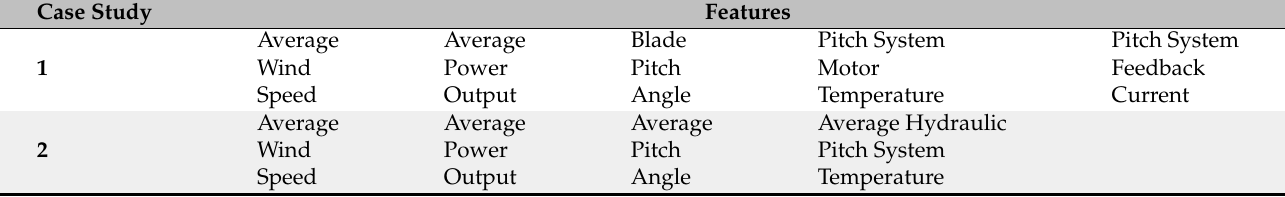
Table 1. Table of features for both Case Studies